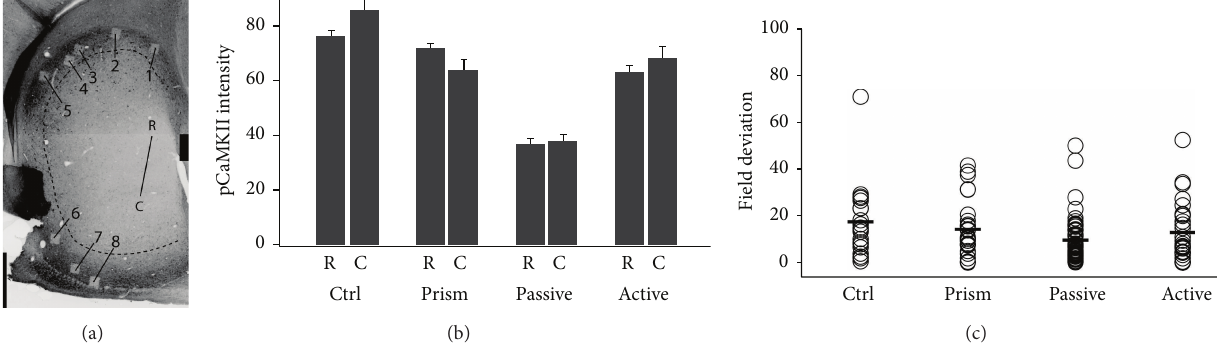
Figure 5: pCaMKII regulation is uniform across the ICX. (a) Representative section after high magnification imaging. Photobleaching of the 63x confocal image fields confirms their location within ICX. Fields 1–5 are located in rostral ICX, which represents frontal auditory space and is subject to optical displacement. Fields 6–8 are located in caudal ICX, which represents peripheral auditory space and is not subject to optical displacement. Rostrocaudal location was assessed according to the criterion in Nichols and DeBello, 2008. (b) Mean pCaMKII intensities for R (rostral) and C (caudal) image fields in all four experimental groups. The differences are small, inconsistent across groups, and not significant (minimum 𝑃 value, Ctrl R versus C, 𝑃 = 0.034 ). (c) Field deviation is the percentage change in mean signal intensity from one image field to its nearest neighbor. Neither comparison was significant: Ctrl versus prism, 𝑃 = 0.53 ; passive versus active, 𝑃 = 0.39 .